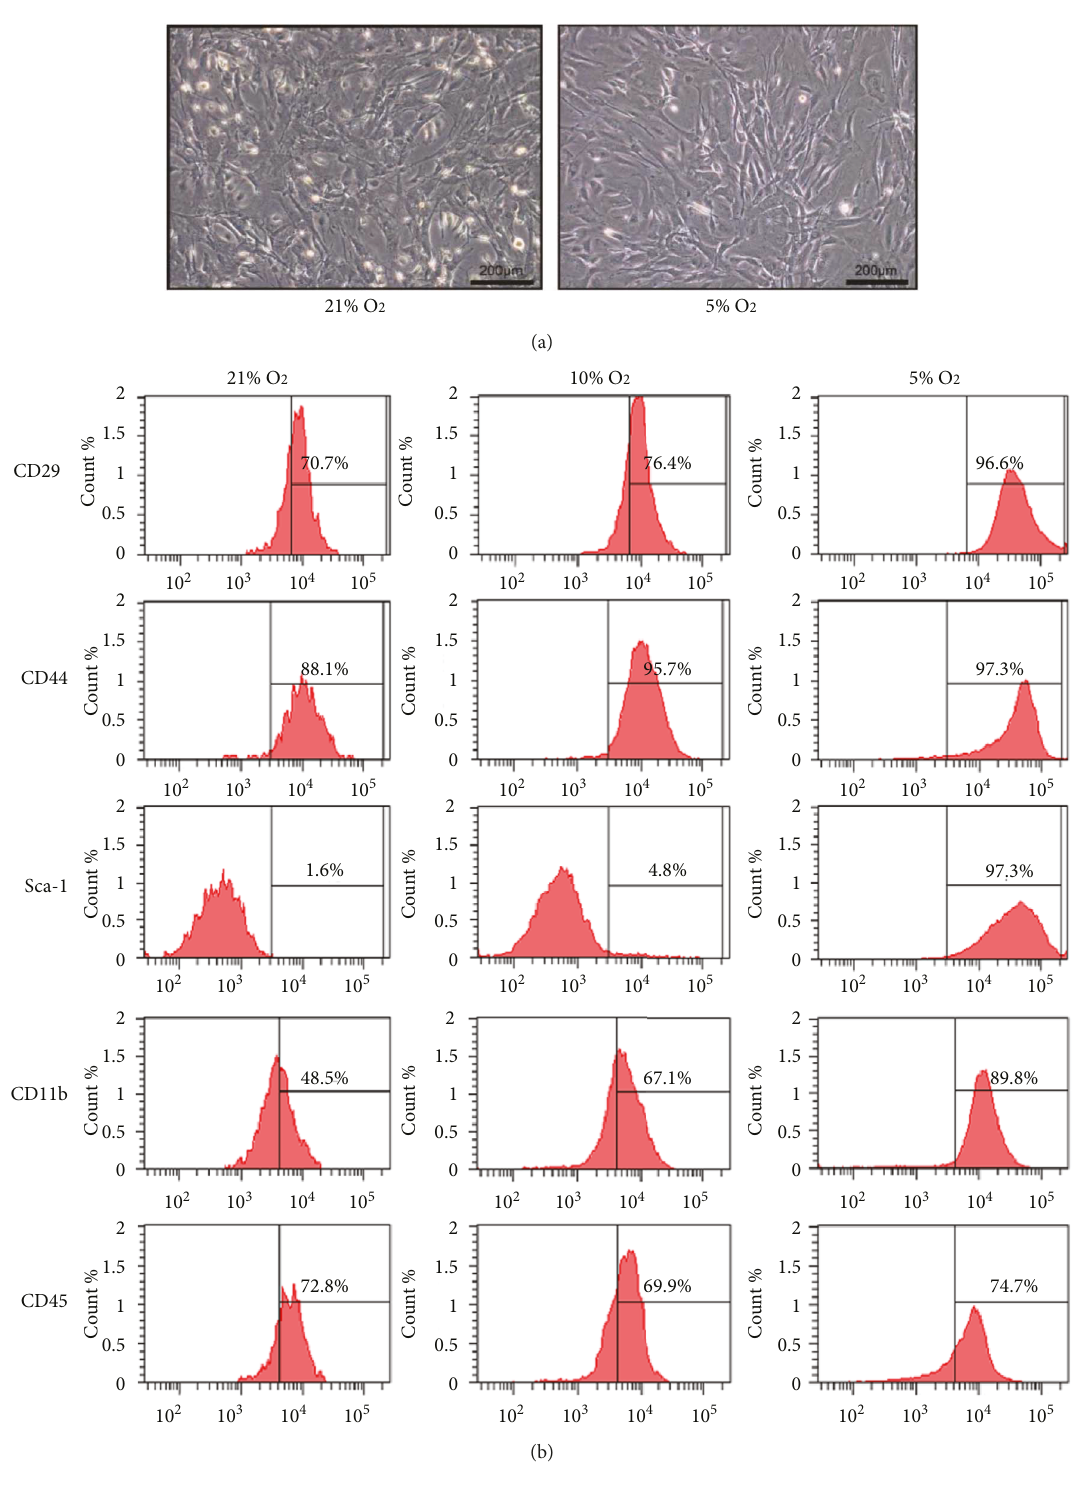
Figure 1: E ff ects of various oxygen concentrations on the cellular morphology and surface markers of BM-MSCs. (a) Representative image of BM-MSCs cultured in 21% and 5% oxygen conditions ( × 100, scale bar =200 μ m). (b) The expression of CD29, CD44, Sca-1, CD11b, and CD45 surface markers determined by fl ow cytometry in BM-MSCs cultured in di ff erent oxygen concentrations (21%, 10%, and